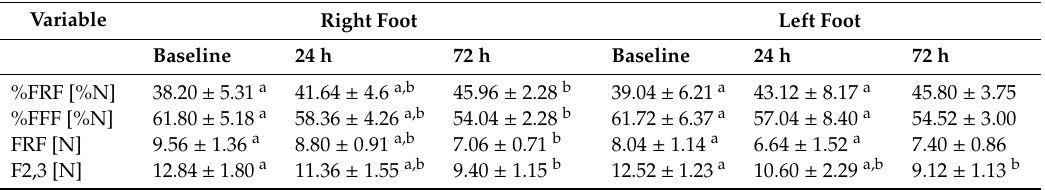
Table 1. Mean Values ( ± SD) of the Plantar Foot Force Distribution Parameters in Futsal Players during 72 h Period of Plantar Fascial Taping.